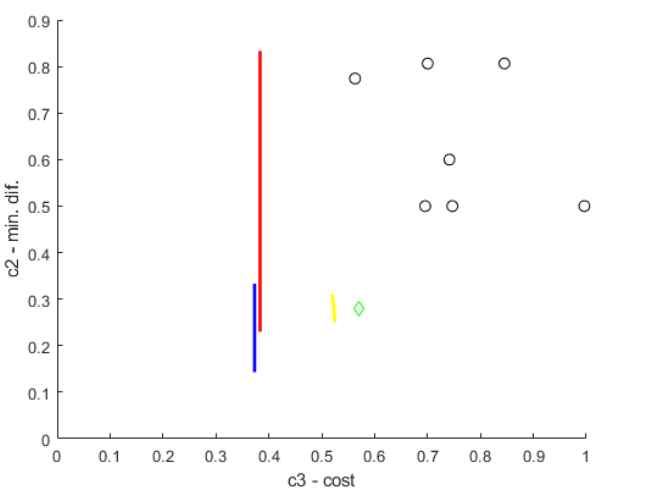
Figure 14. Comparison of crossover